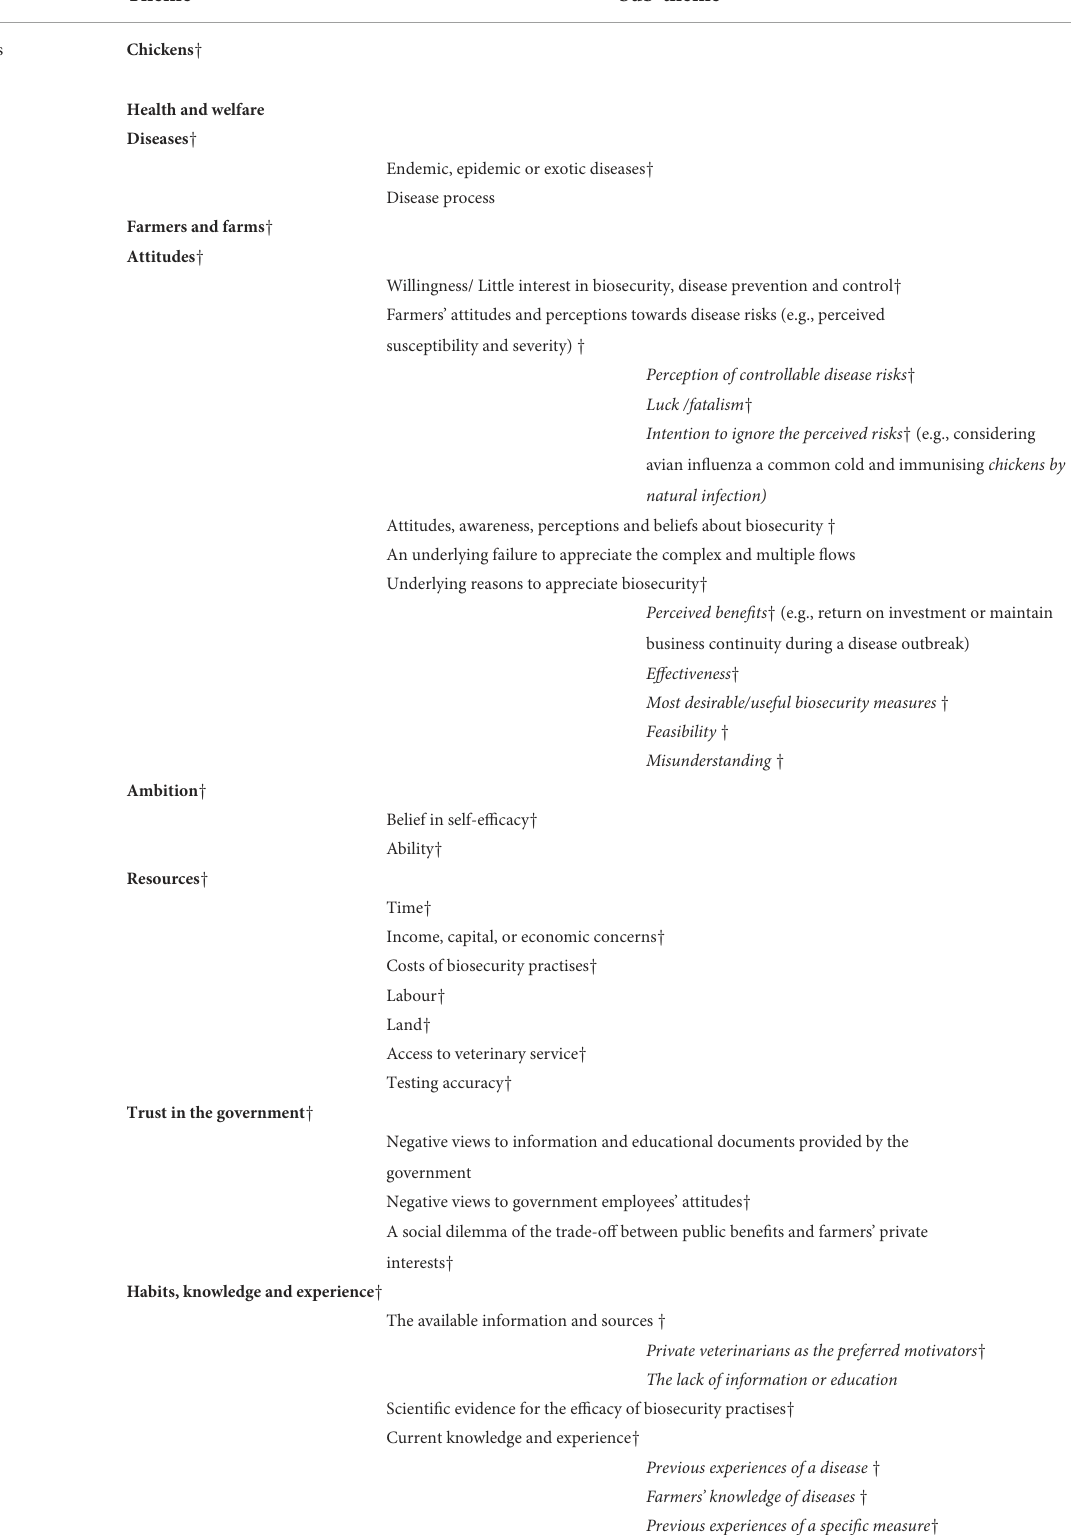
TABLE 1 Factors affecting farmers’ biosecurity mindset identified in the study together with the literature.